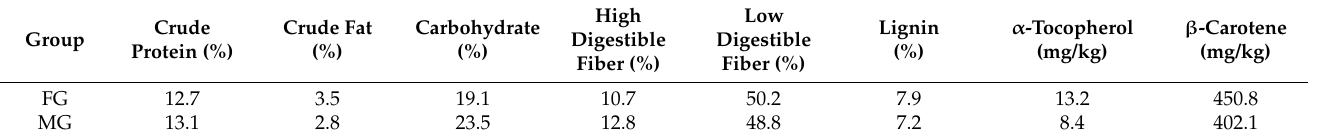
Table 2. The conventional nutrient composition and content of mixed forage grass (calculated in